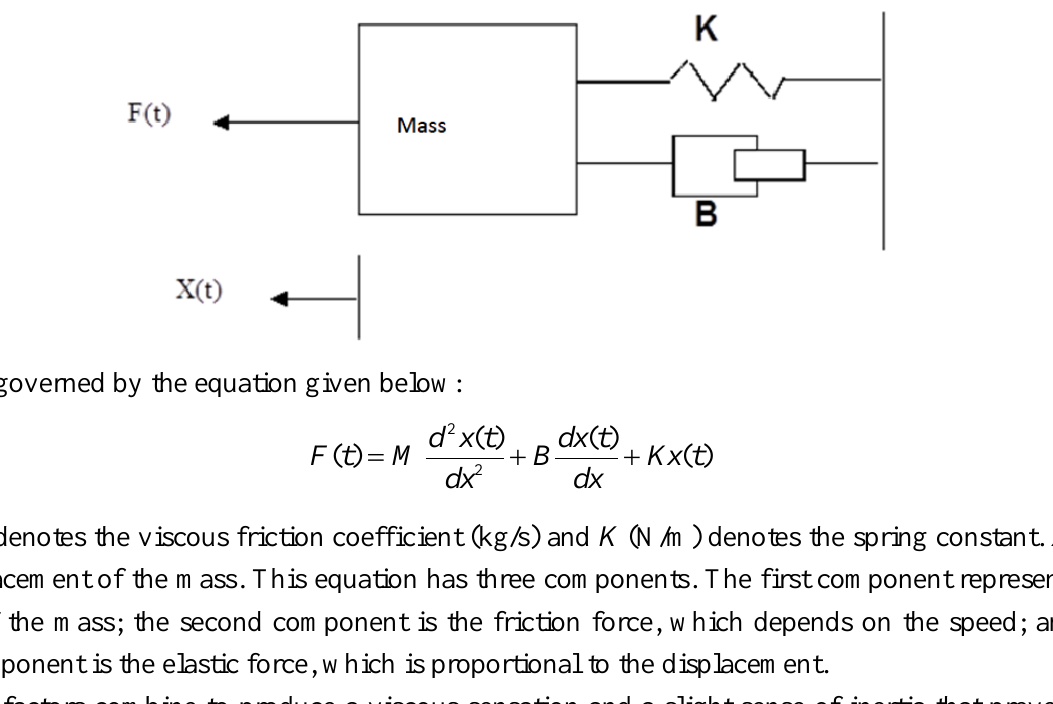
Figure 8. Model of forces exerted on the test